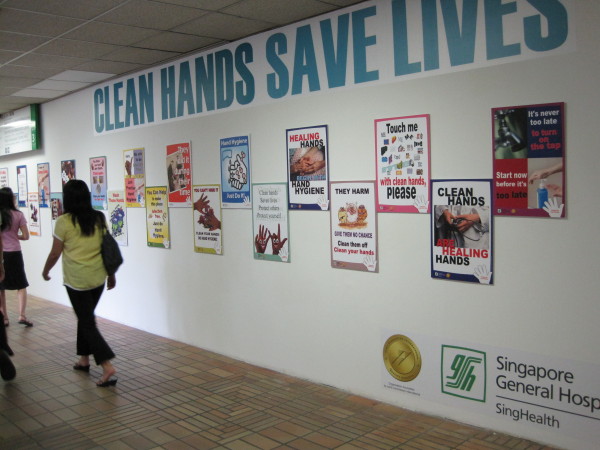
Posters at walkways.